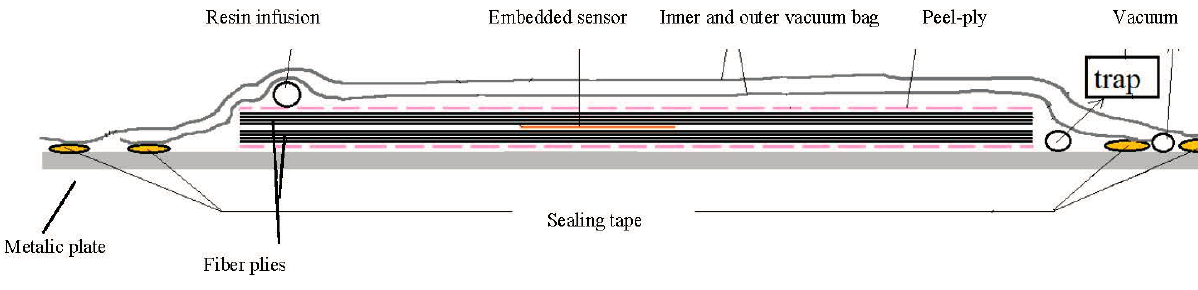
Figure 6. A typical vacuum bag